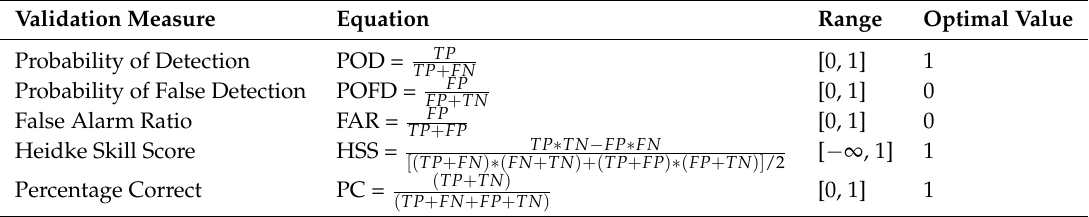
Table 5. Categorical validation measures with equation, range of values and optimal value [59,60]. Validation